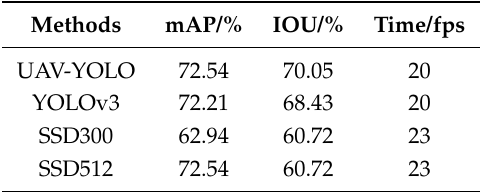
Table 3. Comparison results with state-of-the-art one-stage detection method on selected human samples from VOC/COCO.